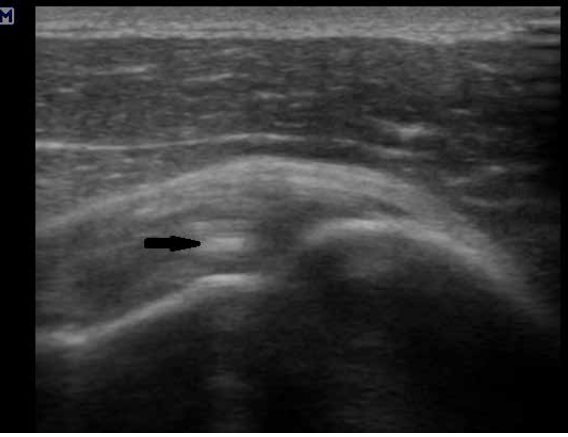
Figure 2: Calcyfications in supraspinatus tendon (black arrow). Table 3: Dominant hand vs normal/enthesopathy (USG